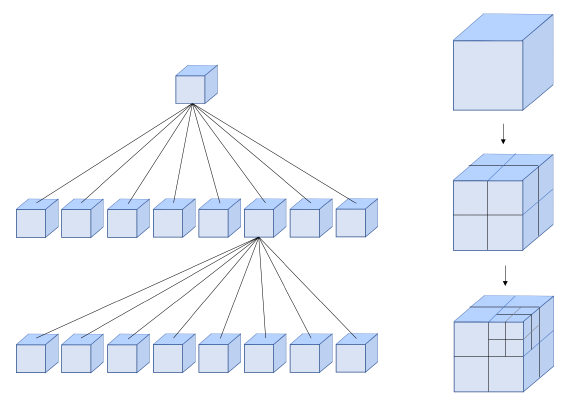
Figure 5. Octree